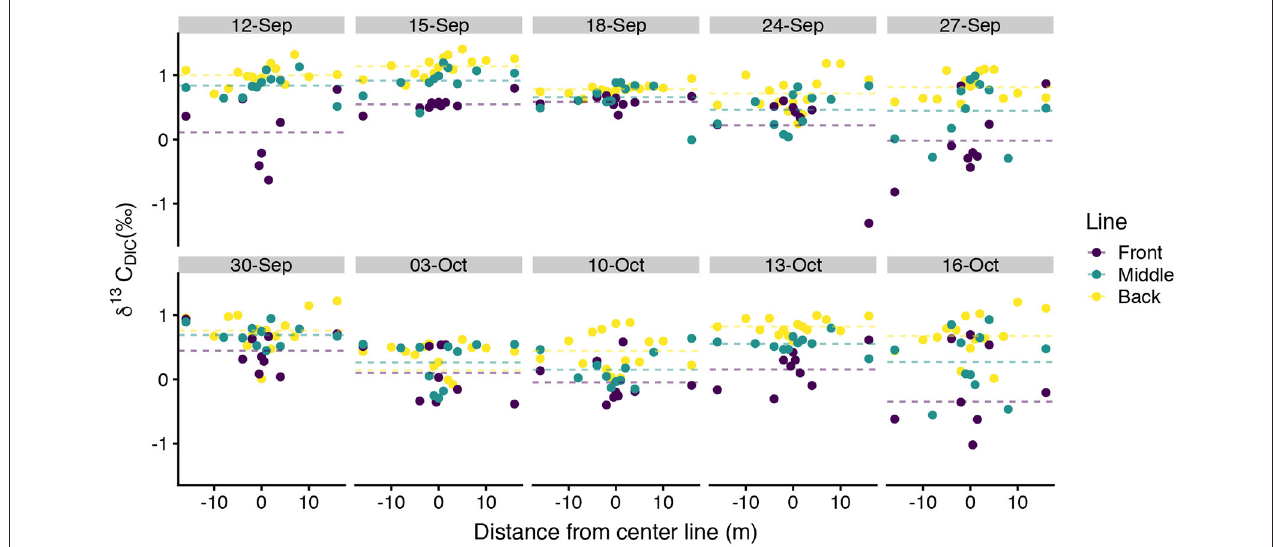
FIGURE 5 | Spatial distribution of δ 13 C DIC measurements. Spatial distance values less than zero are located north of the center line and distance values greater than zero are located south of the center line in Figure 1 . Dotted lines show line-averaged δ 13 C DIC . Two anomalously low δ 13 C DIC samples, one on 03-October-2016 and the other on 16-October-2016, extend beyond the y-axis of this plot and are shown in Figure 6 .